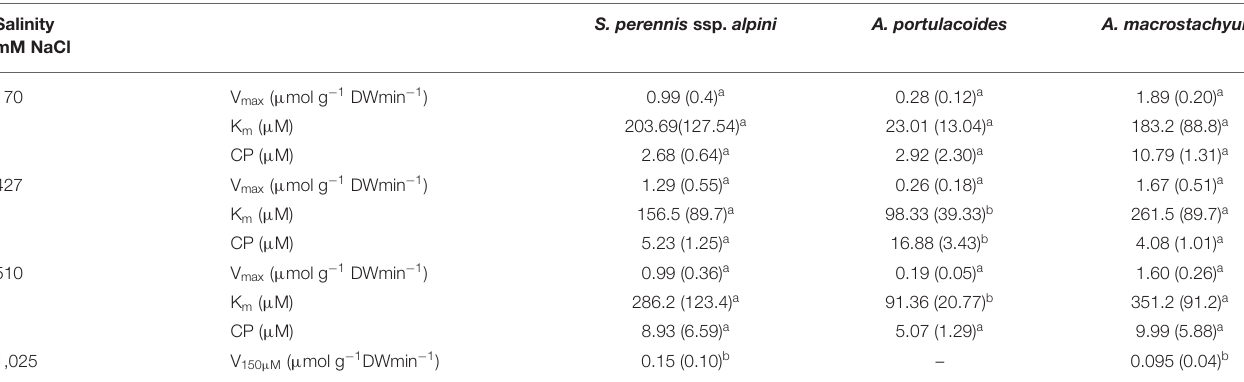
TABLE 4 | Kinetic parameters of phosphate uptake curves measured at different salinities in the three species of this study. Salinity mM